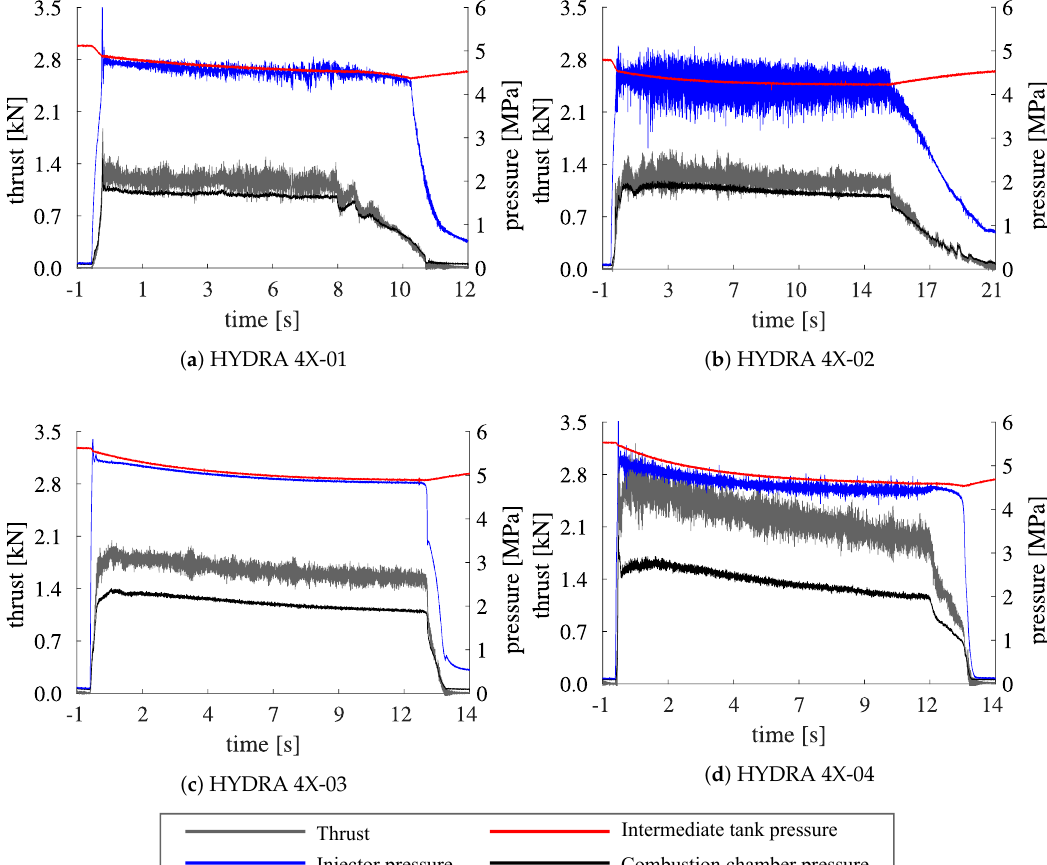
Figure 6. Engine test data for HYDRA 4X-01 ( a ), 4X-02 ( b ), 4X-03 ( c ), and 4X-04 ( d